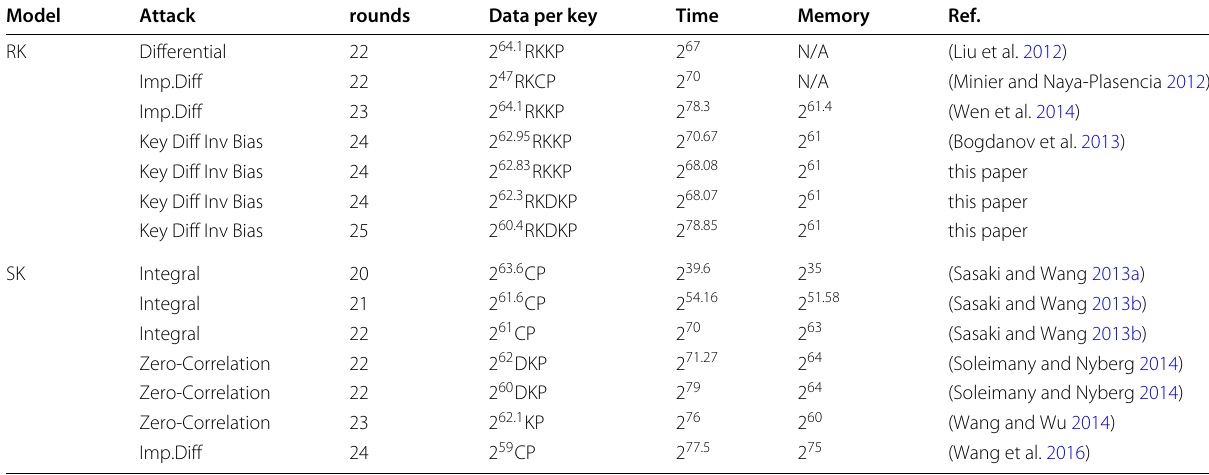
Table 1 Comparison of key-recovery attacks on LBlock Model